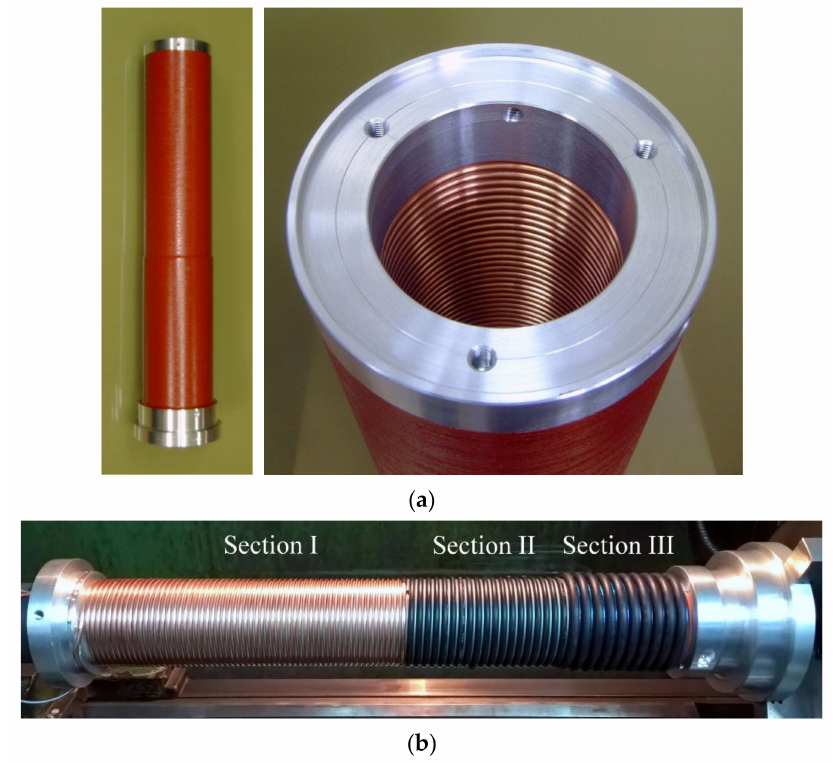
Figure 4. Photographs of the FCG model ( a ), and a winding with a visible division into sections of different lengths and wire cross-sections, with air and solid insulation respectively ( b ). Table 1. FCG model parameters.